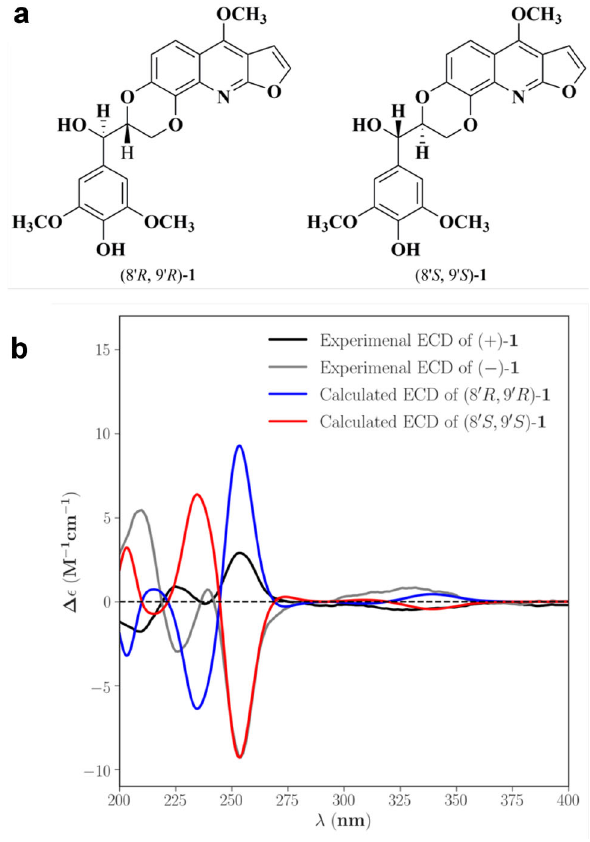
Fig. 4 a Two possible stereochemical structures of 1 ; b experimental ECD spectra of ( ? )- 1 /( - )- 1 and calculated ECD spectra of (8 0 R , 9 0 R )/ (8 0 S , 9 0 S ) of